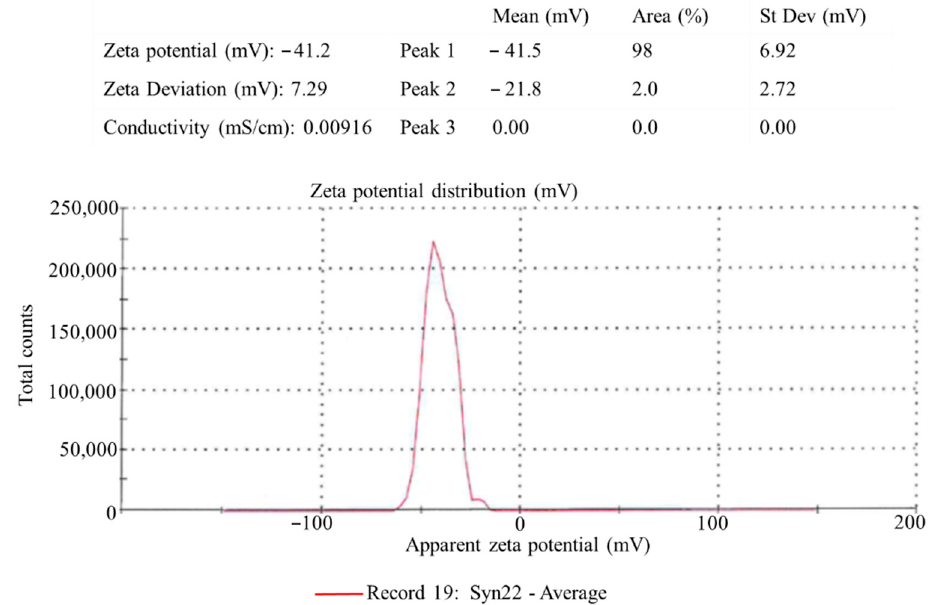
Figure 7. Zeta potential analysis of gold nanoparticles. Zeta potential distribution of gold nanopar- ticles synthesized by soluble extracts from recombinant E. coli cells